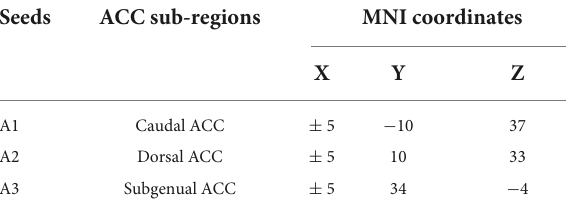
number of slices = 176, thickness = 1.0 mm, gap = 0.5 mm, matrix = 256 × 256, FA = 9 ◦ , FOV = 256 mm × 256 mm, voxel size = 1 × 1 × 1 mm 3 . The imaging process took approximately 4.26